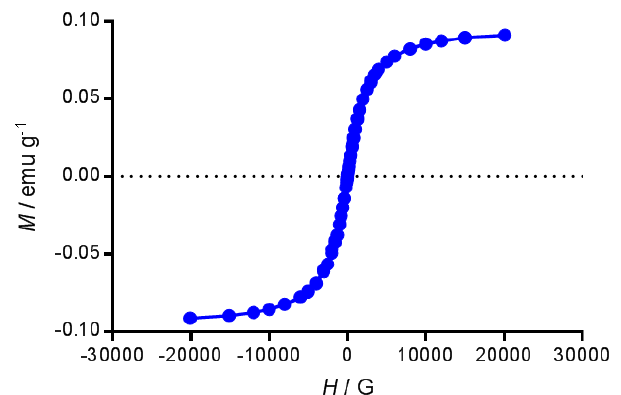
Figure 3. Mass magnetization as a function of the external magnet field for magnetic particles coated with oleic acid at 300 K. The external magnetic field was swept from 20,000 to − 20,000 G and then back to 20,000 G.